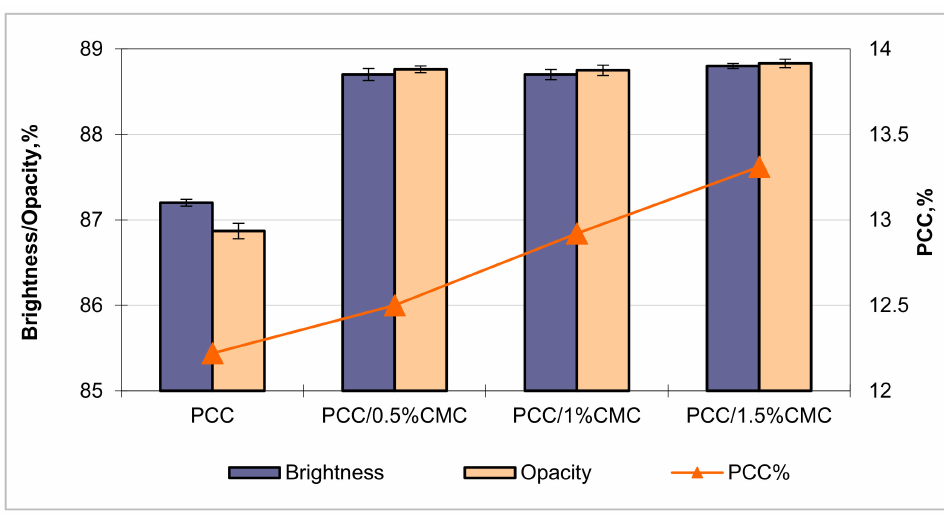
Figure 8. Brightness and opacity of paper